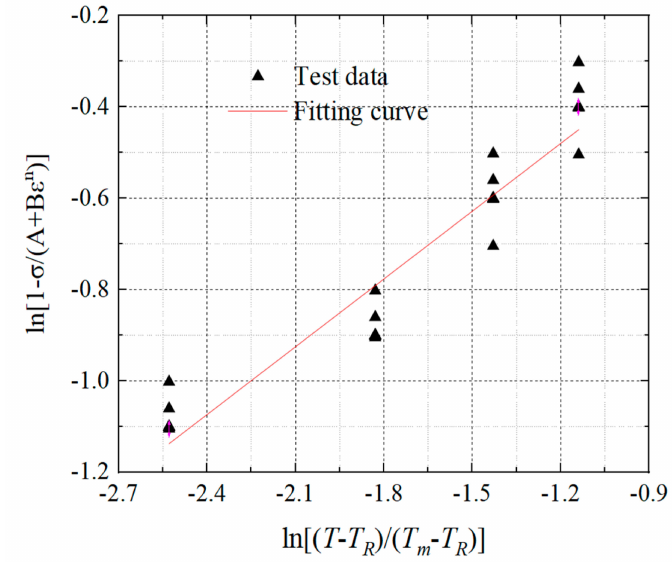
Figure 7. The relationship between ln(